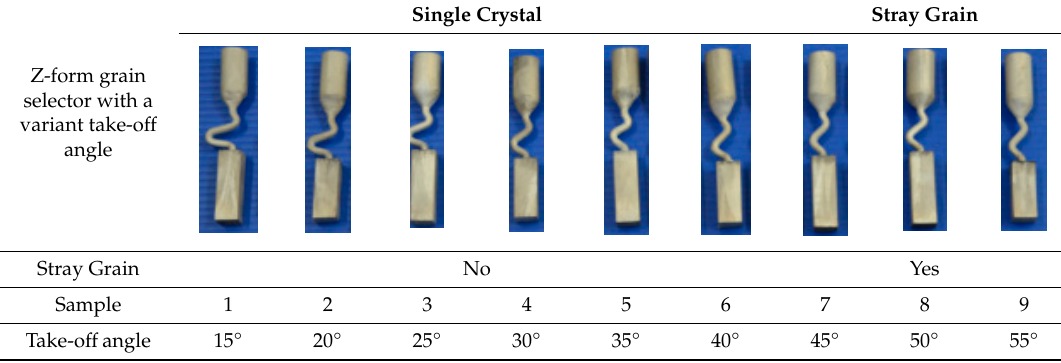
Table 4. Geometry of the selector design when varying the take-off angle: Group 2.